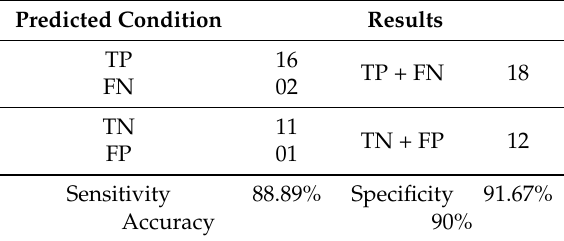
Table 3. Human activity monitoring result